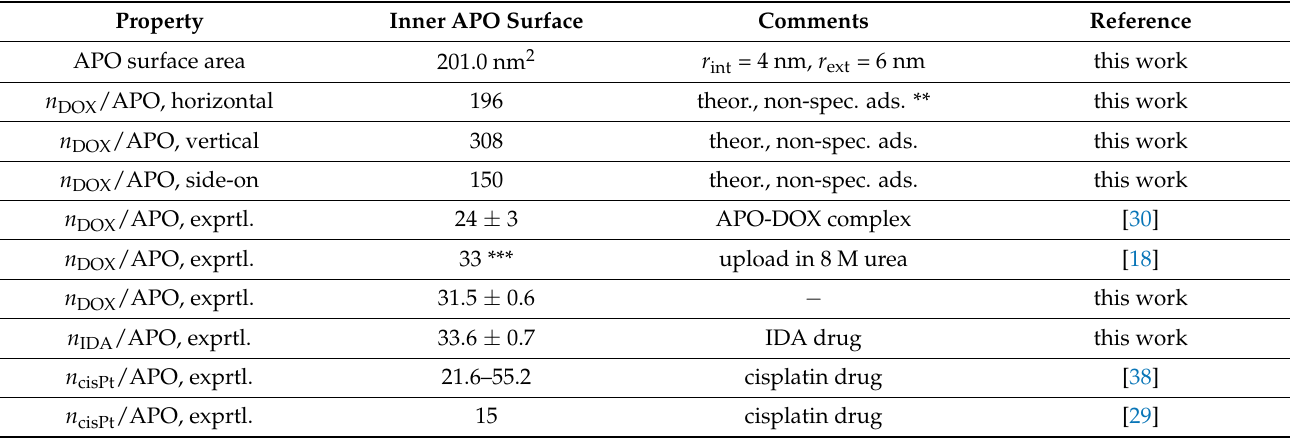
Table 3. Comparison of experimental DOX encapsulation excess n for APO(DOX n ) nanocarriers * with theoretical data for nonspecific adsorption of DOX on inner APO surface at maximum